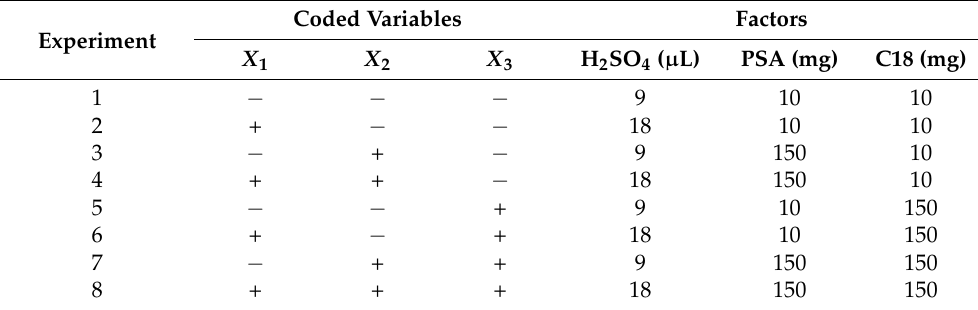
Table 2. Experimental design matrix with coded variables and real factor levels.